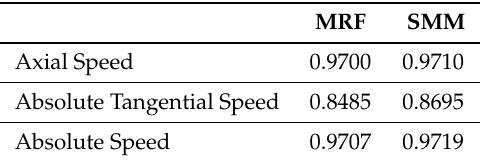
Table 2. Comparison of the Mean Square Error Percentage (MSEP) for the Multiple Reference Frame model (MRF) and Sliding Mesh Model (SMM) in the case of the three speed